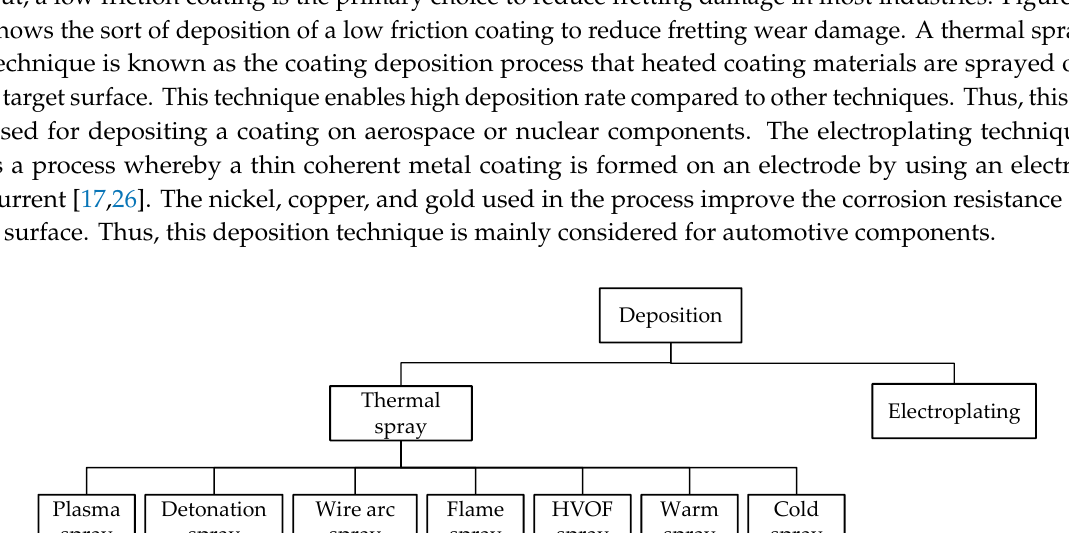
Figure 8. Kind of deposition of a low friction coating [19].